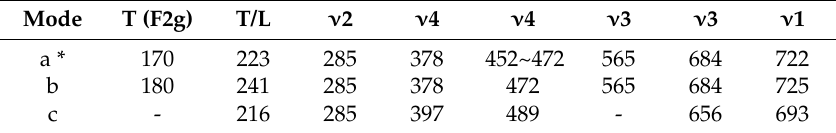
Table 1. Assignments of Raman shifts for CuFe 2 O 4 /NG.